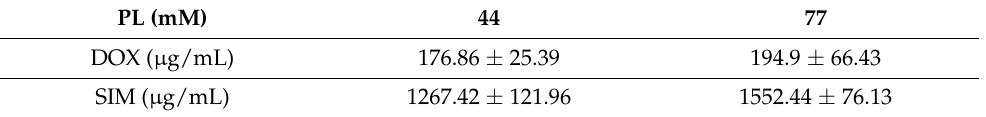
Table 1. The composition of the formulations used for in vitro drug release